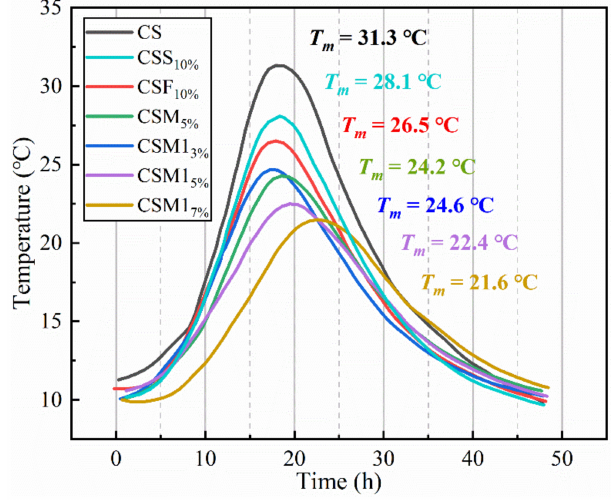
Figure 14. Hydration temperature of cement slurry samples.